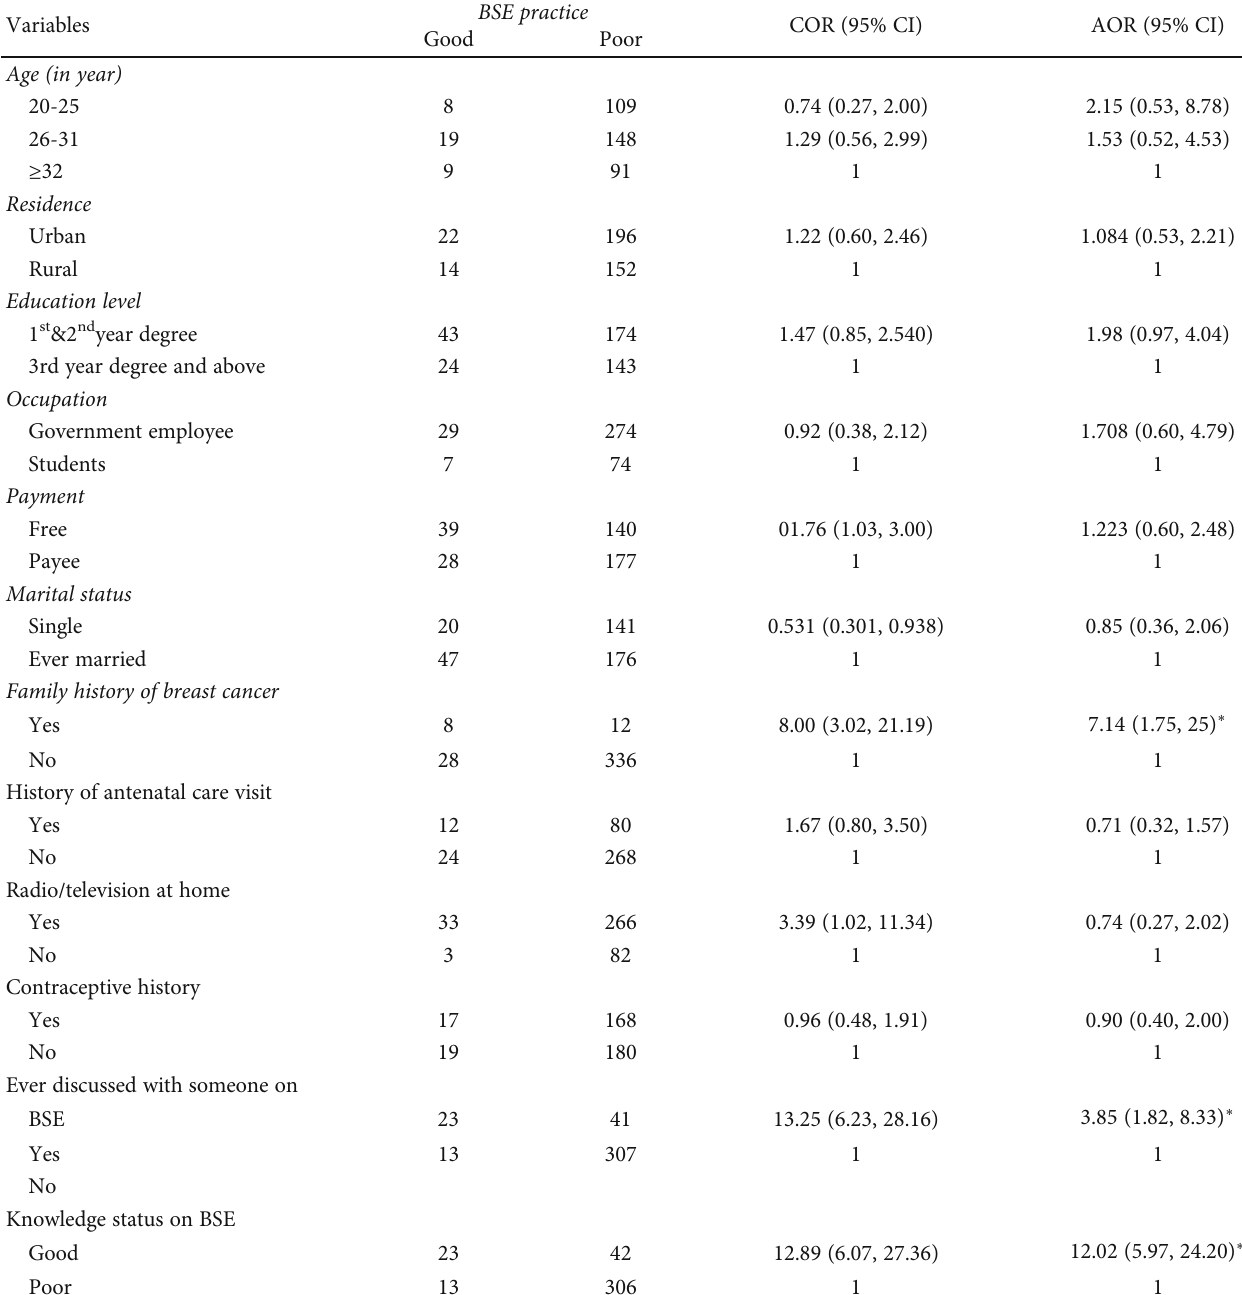
Table 5: Factors associated with practice of BSE among summer social science female students in University of Gondar, Northwest Ethiopia, 2018 ( n = 384